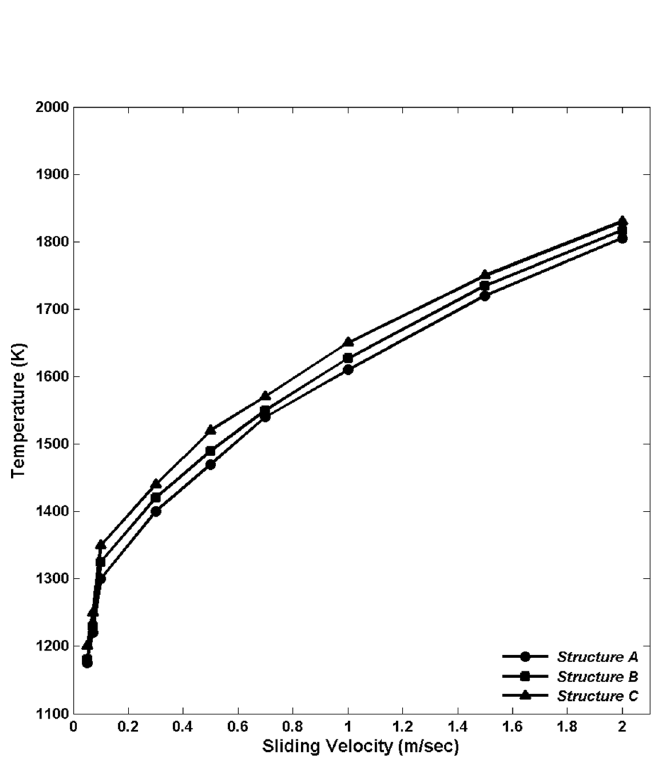
Figure 3. Maximum interfacial temperature during flash heating events across the entire spectrum of simulated velocities and